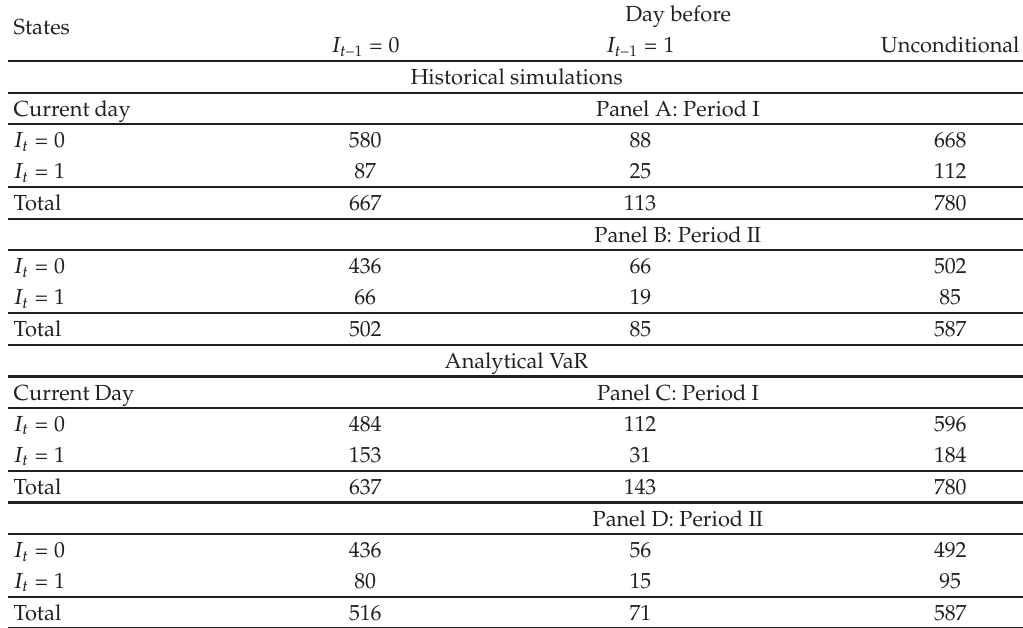
Table 7: Model accuracy using christo ff ersen’s independence test for a large